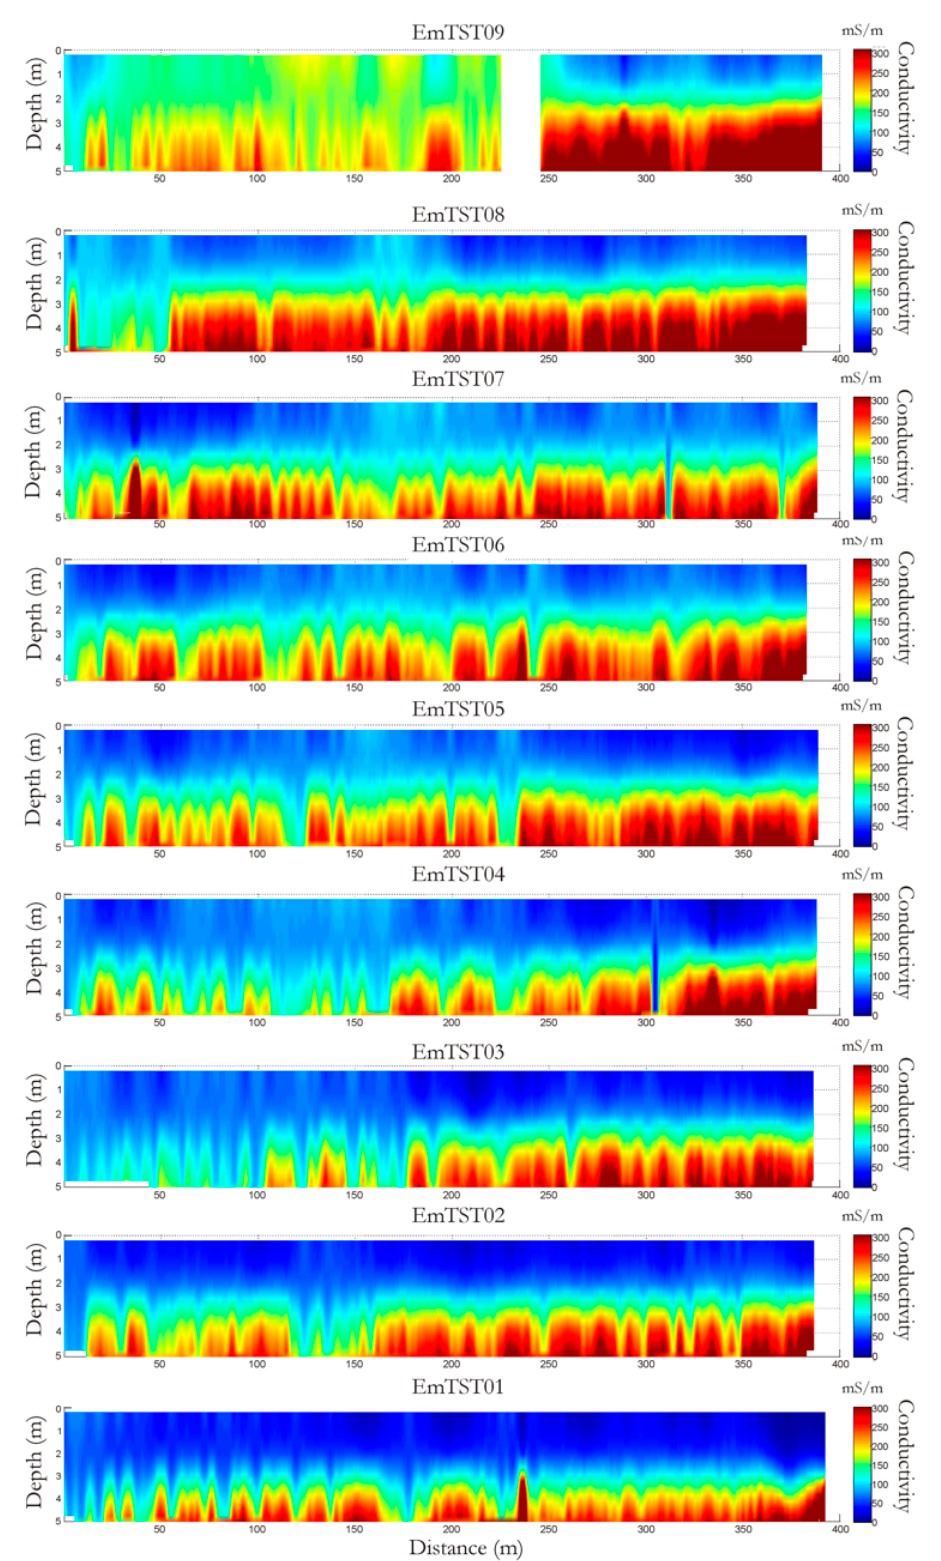
Figure 4. Electrical conductivity profiles as extracted by the EMP-400 profiler from the studied field.